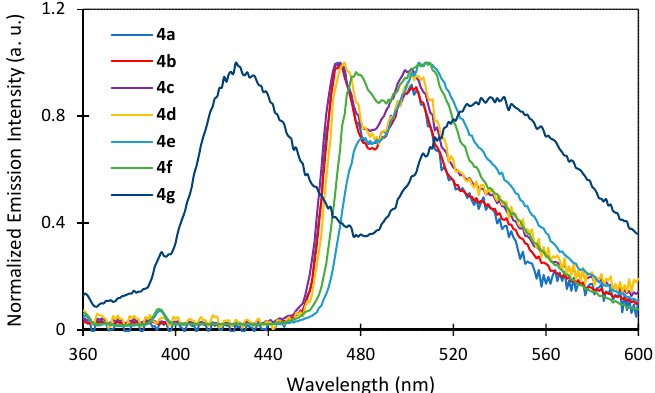
Figure 7. Normalized absorption spectra of complexes 4a to 4g in CH 2 Cl 2 at 298 K. The luminescence spectra of complexes 4a to 4f in CH 2 Cl 2 at 298 K are shown in Figure 8 and their photophysical data are summarized in Table 1. After excitation at 360 nm, all the complexes, except 4g , showed similar blue–green emission, with two maximum wavelengths around 470 and 500 nm, respectively. The neutral iridium complex 4g displayed a dual blue and green emission, with two maxima at 425 nm and 535 nm. All the complexes showed vibronically structured phosphorescence spectra in the CH 2 Cl 2 solution at room temperature, which indicated that the emissive excited state had both LC π → π * and MLCT characters [72].